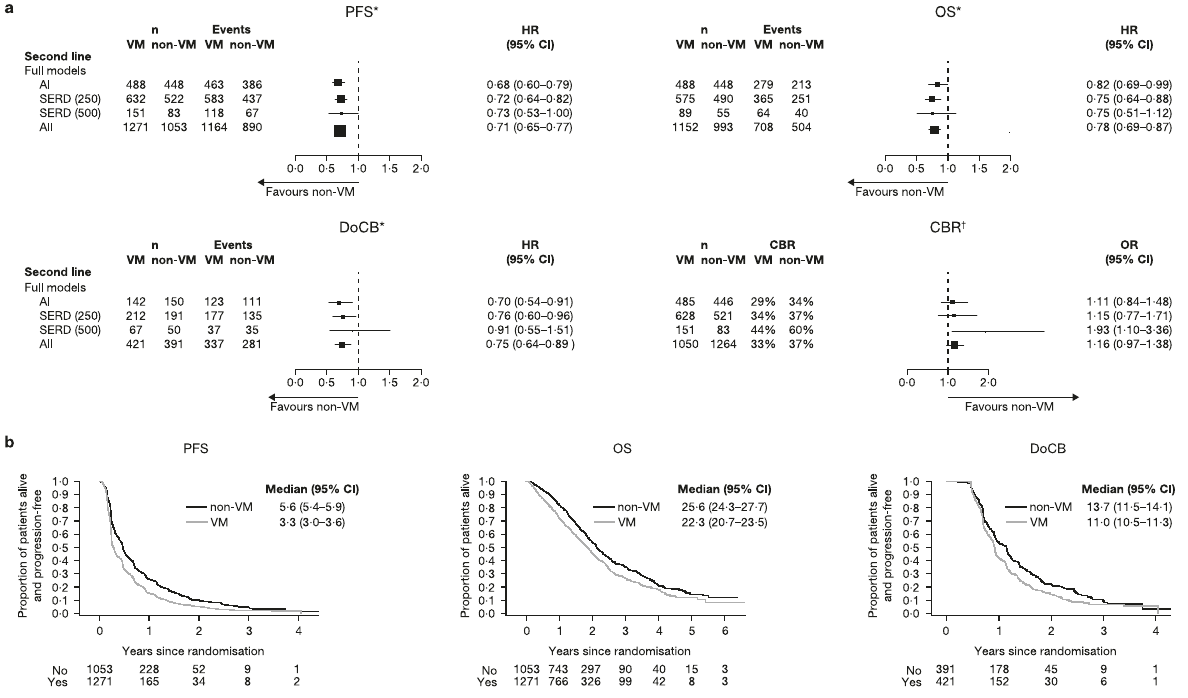
Fig. 5 Clinical outcomes for VM versus non-VM in the second-line setting. a Forest plots of PFS, OS, DoCB and CBR. * Fixed effect for trial was fi tted in all models. † Fixed-effect model was fi tted to the SERD 250 mg, SERD 500 mg and all data; random effects for trial were included in the models for AI. b Projected probability of PFS, OS and DoCB. Median (95% CI) PFS/OS/DoCB in months. AI aromatase inhibitor, CBR clinical bene fi t rate, DoCB duration of clinical bene fi t, HR hazard ratio, n number of patients, non-VM non-visceral metastases, PFS progression-free survival, OR odds ratio, OS overall survival, SERD selective estrogen receptor degrader, SERM selective estrogen receptor modulator, VLM visceral liver metastases, VM visceral metastases, VnLM visceral non-liver metastases. Statistics for full models:PFS: AI: p < 0·001, heterogeneity test p = 0·13; SERD (250 mg): p < 0·001, heterogeneity test p = 0·08; SERD (500 mg): p = 0·048, heterogeneity test p = 0·83; All: p < 0·001, heterogeneity test p = 0·17. OS: AI: p = 0·036, heterogeneity test p = 0·35; SERD (250 mg): p < 0·001, heterogeneity test p = 0·95;